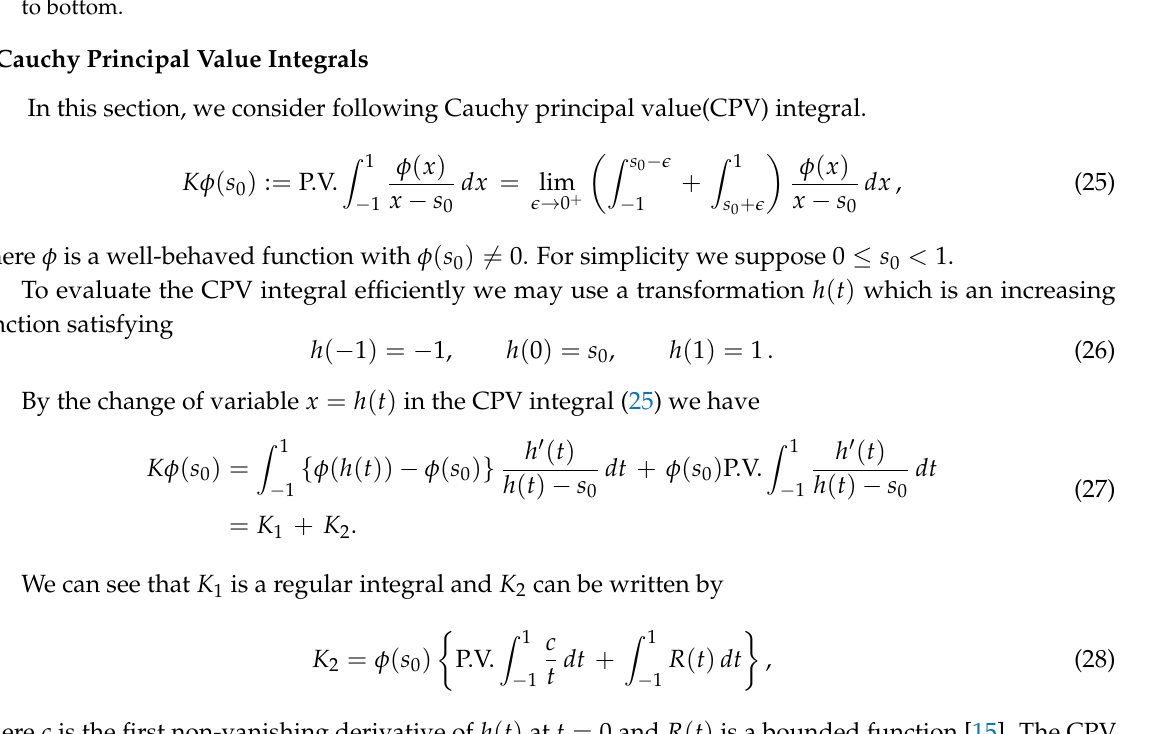
Figure 4. Relative errors of (cid:101) f m ( k ; t ) , 1 < k < 15, for the end-point logarithmic singular integral J φ ( ξ 0 ) , with ξ 0 = 1, in Example 2. Dotted horizontal lines indicate relative errors of P Sat m ( t ) for m = 5,7,9 from top to